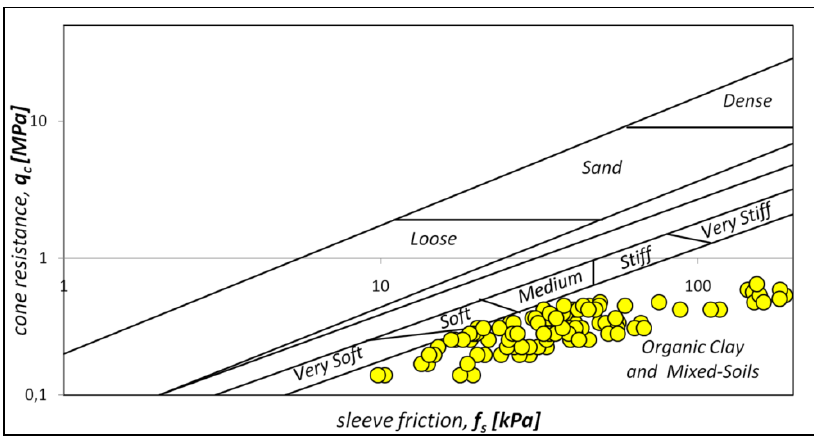
Figure 6. Diagrams present the identification of organic soils based on CPTM tests, according to the propositions of Schmertmann’s nomogram and taking into account Bergman’s criterion.